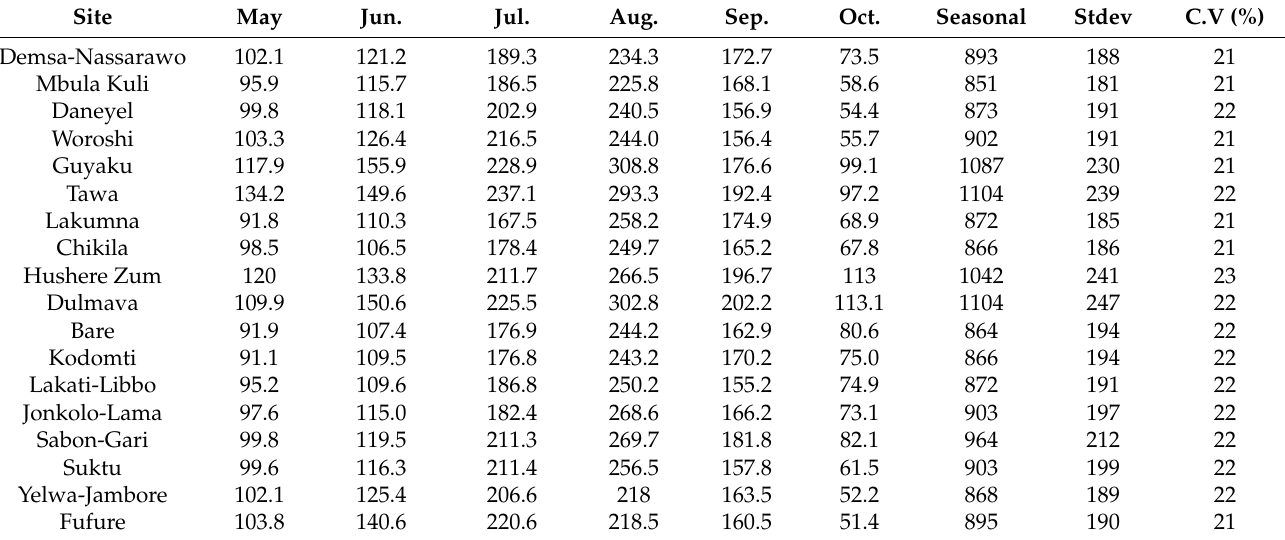
Table 7. Analysis of mean monthly, seasonal rainfall (mm) and level of variability across the simula- tion sites in Adamawa State